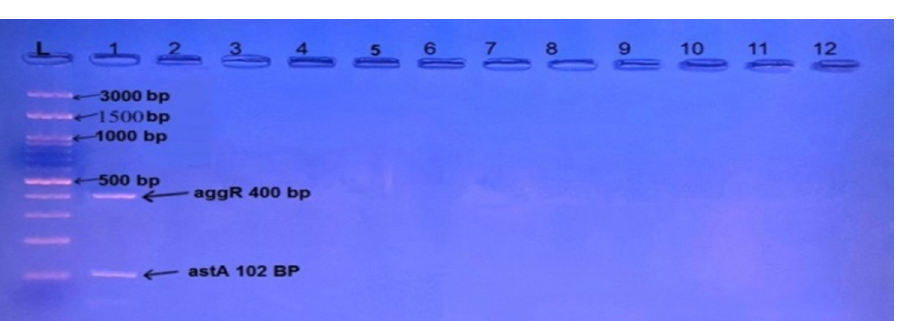
Fig. 5. Gel electrophoresis of amplified (eaeA, bfpB, aggR, astA, pic, hly, stx1, stx2, invE, ipaH, elt, estIa, estIb ) genes, the product size (482, 910, 400, 102, 1, 111, 688, 244, 324, 766, 437, 655, 157, 171 (bp) respectively), of E .coli strains using conventional PCR . Agarose 2%, and TBE(1X ) at (75 V/cm for 90 min., stained with Ethidium bromide dye and visualized on a UV transilluminator. Lane (L): DNA ladder (100-3000bp), Lanes: (1-12) stool sample.